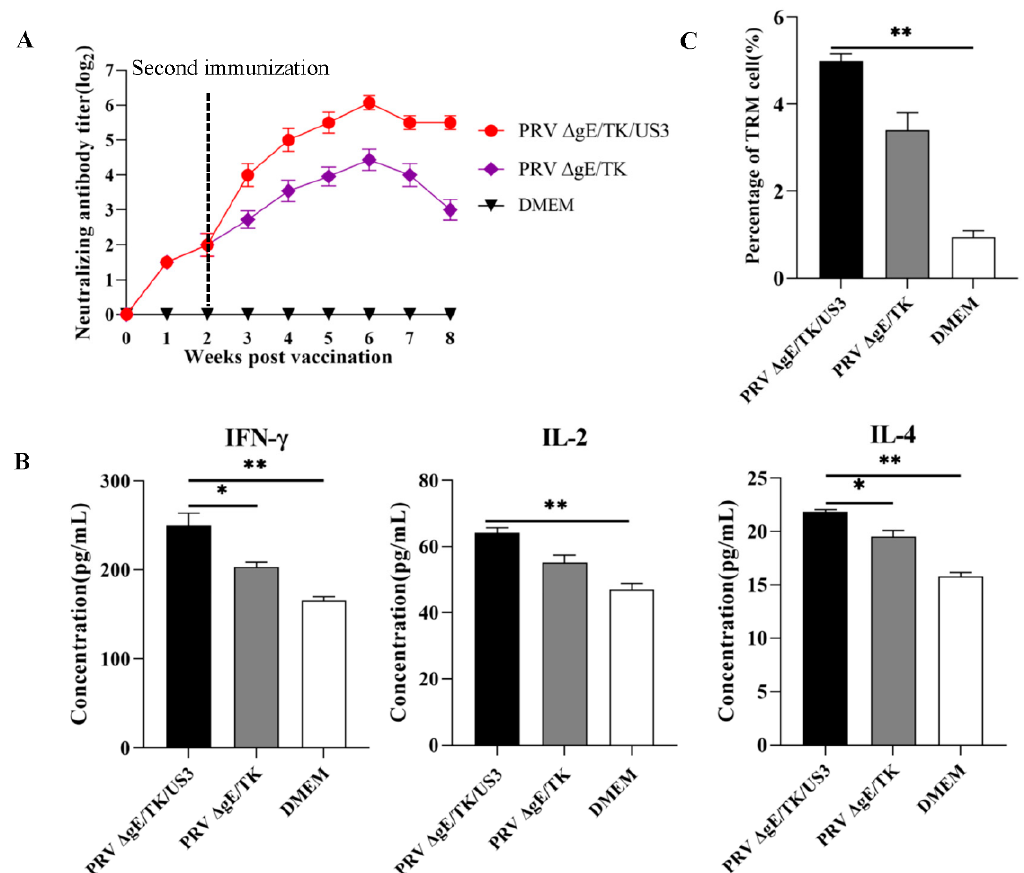
Figure 7. The immunogenicity of PRV Δ gE/TK/US3 in mice ( A ) Neutralizing antibody titer was examined in the serum of vaccinated mice. ( B ) The expression levels of cytokines IFN- γ , IL-2, and IL-4 in the peripheral serum of vaccinated mice were detected by ELISA. ( C ) The number of CD8 + CD69 + TRM cells in trigeminal ganglion of vaccinated mice was detected by flow cytometry. Data was presented as mean ± SD.* p < 0.05, ** p < 0.01.